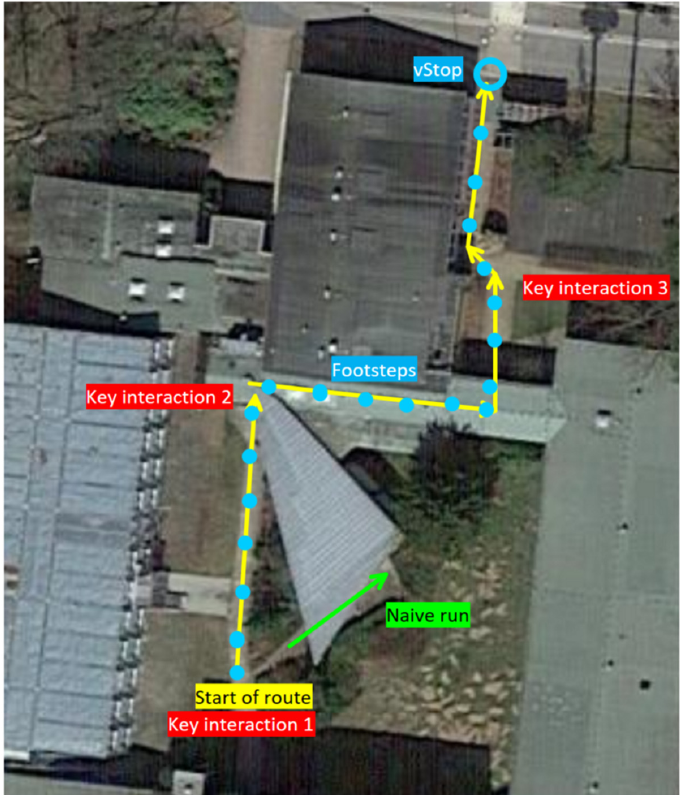
Figure 3. Overview of the test area of second user study. Green: naïve run route; yellow: field study navigation route; blue: AR ‐ prototype information elements (path breadcrumbs and vStop); and red: situations of key interaction with the HMI (taken from Google Maps with own markings).